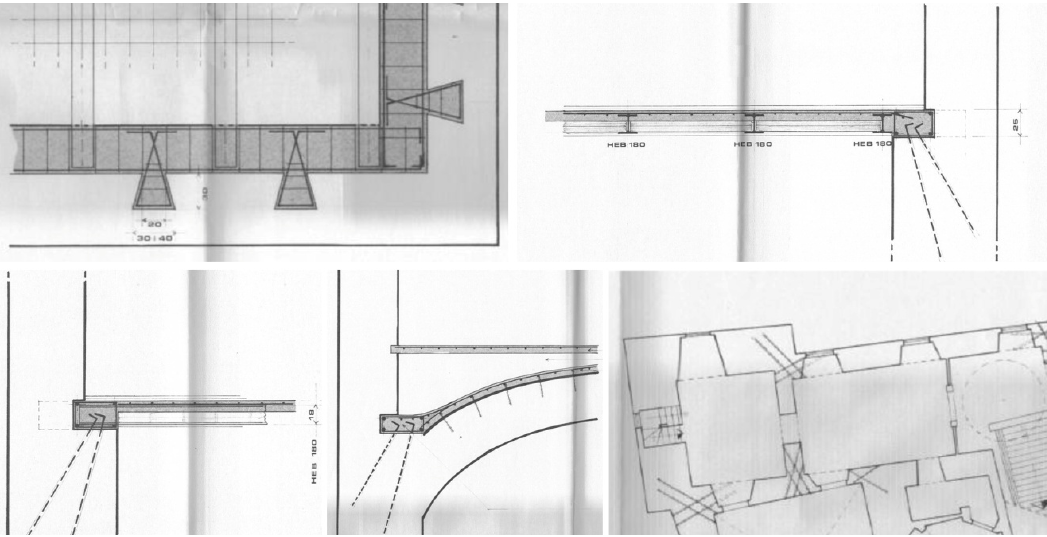
Figure 9. Some construction details included in the project of restoration of the central part of the castle (from design documentation: arch. Giuseppe Zampino,